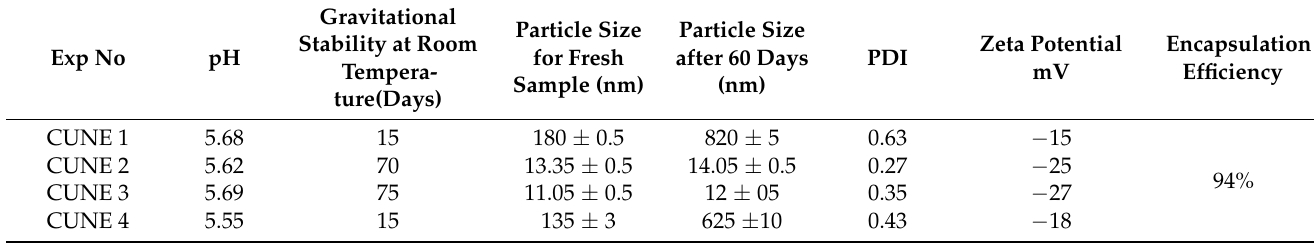
Table 1. pH and gravitational stability of nanoemulsions data.